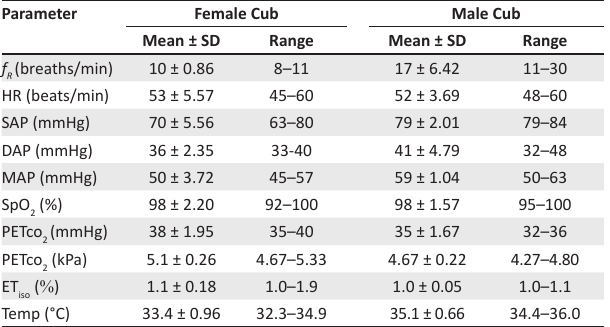
TABLE 1: Cardiopulmonary and expired gas values during anaesthesia of two Bengal tiger ( Panthera tigris tigris ) cubs undergoing surgical reduction of femur